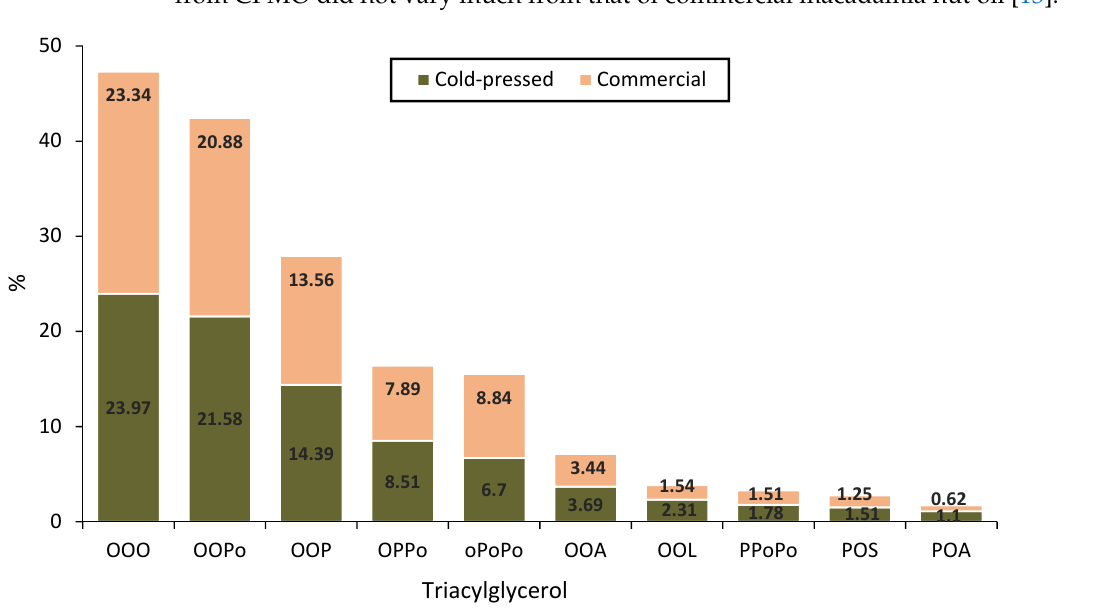
Figure 3. The primary triacylglycerol components (%) of cold-pressed and commercial macadamia nut oils.OOO-dioleoyl-palmitoleoyl-glycerol, OOPo-dioleoyl-palmitoleoyl-glycerol, OOP-dioleoyl- palmitoyl-glycerol, OPPo-oleoyl-palmitoyl-palmitoleoyl-glycerol, OPoPo-oleoyl-dipalmitoleoyl- glycerol, OOA-dioleoyl-arachidoyl-glycerol, OOL-dioleoyl-linoleoyl-glycerol, PPoPo-palmitoyl- dipalmitoleoyl-glycerol, POS-palmitoyl-oleoyl-stearoyl-glycerol, POA-palmitoyl-oleoyl-arachidoyl- glycerol. Adapted from Tan et al. [13]